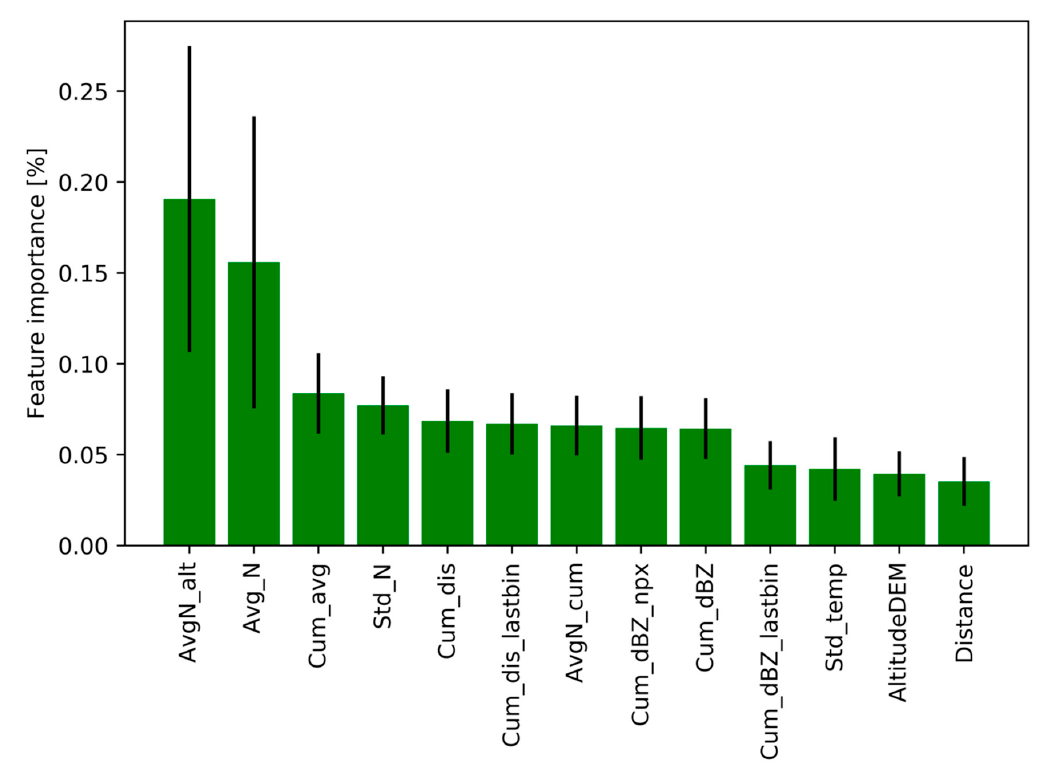
Figure 6. Feature importance and its standard deviation on the RF model. Out-of-bag (OOB) error was used to rank the features in the training stage.